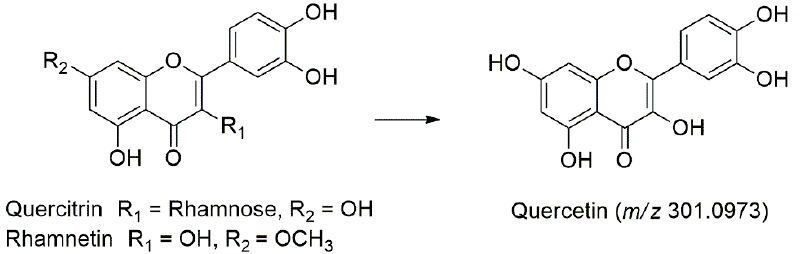
Figure 4. The main fragmentation pathways of the quercetin derivatives.